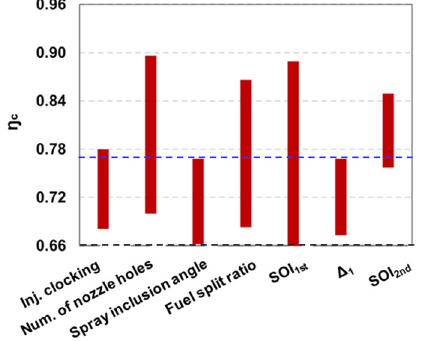
Figure 3. Effects of different design variables on combustion efficiency (ŋ c ) under a spark-assisted cold idle operation in an HD GCI engine.